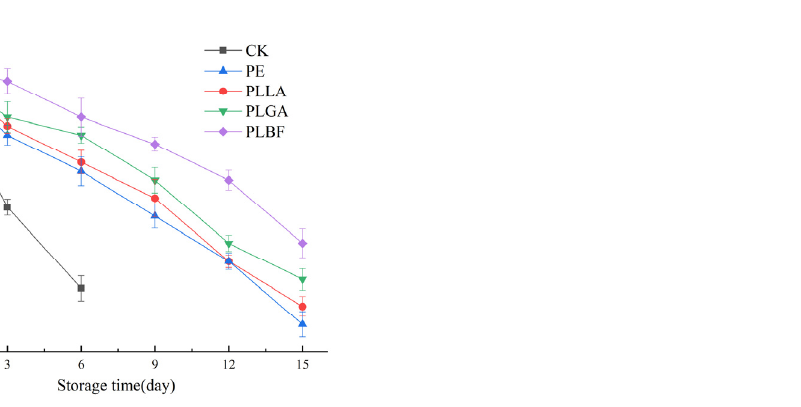
Figure 8. Changes of total ascorbic acid of Agaricus bisporus in each packaging group during storage.